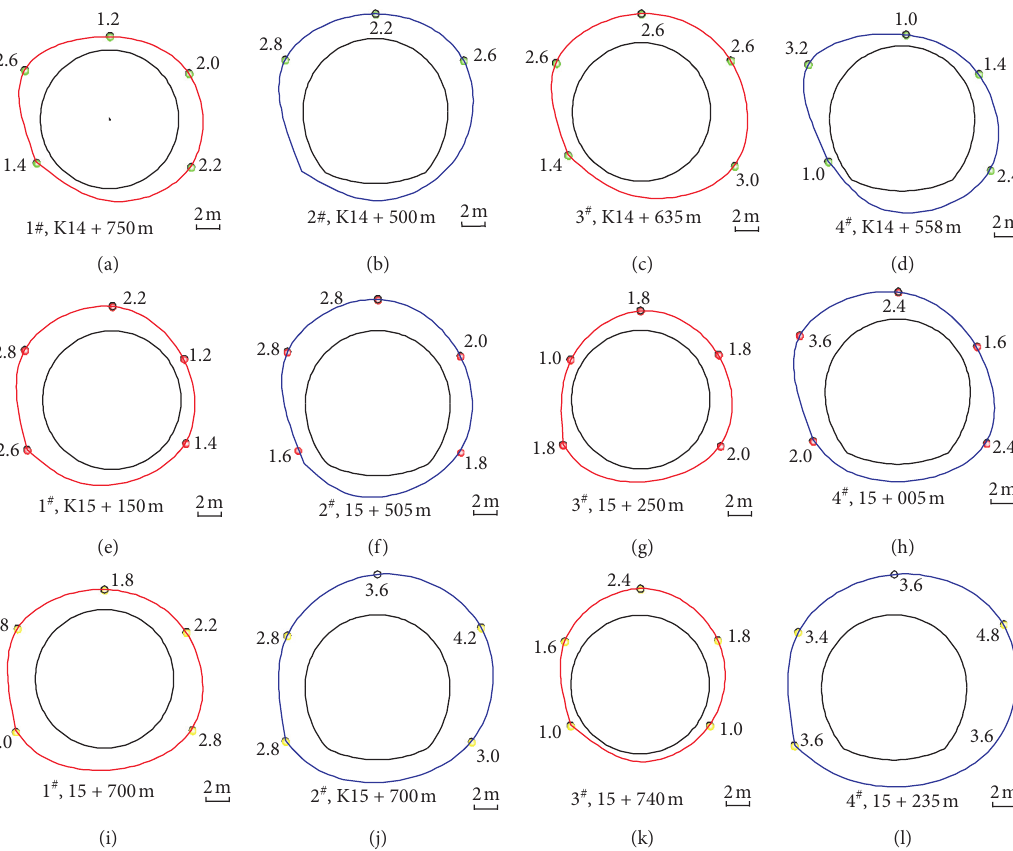
Figure 6: Typical cross sections of relaxation ranges measured by acoustic monitoring for rock mass of 1 # –4 # diversion tunnel: (a) ∼ (d) nearby k14 +500m, (e) ∼ (h) nearby k15 +200m, and (i) ∼ (l) nearby